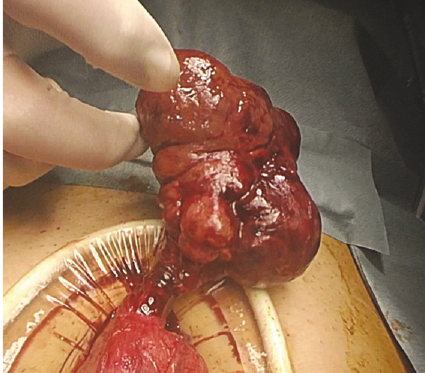
Figure 2: The lesion was found to cause torsion and congested.